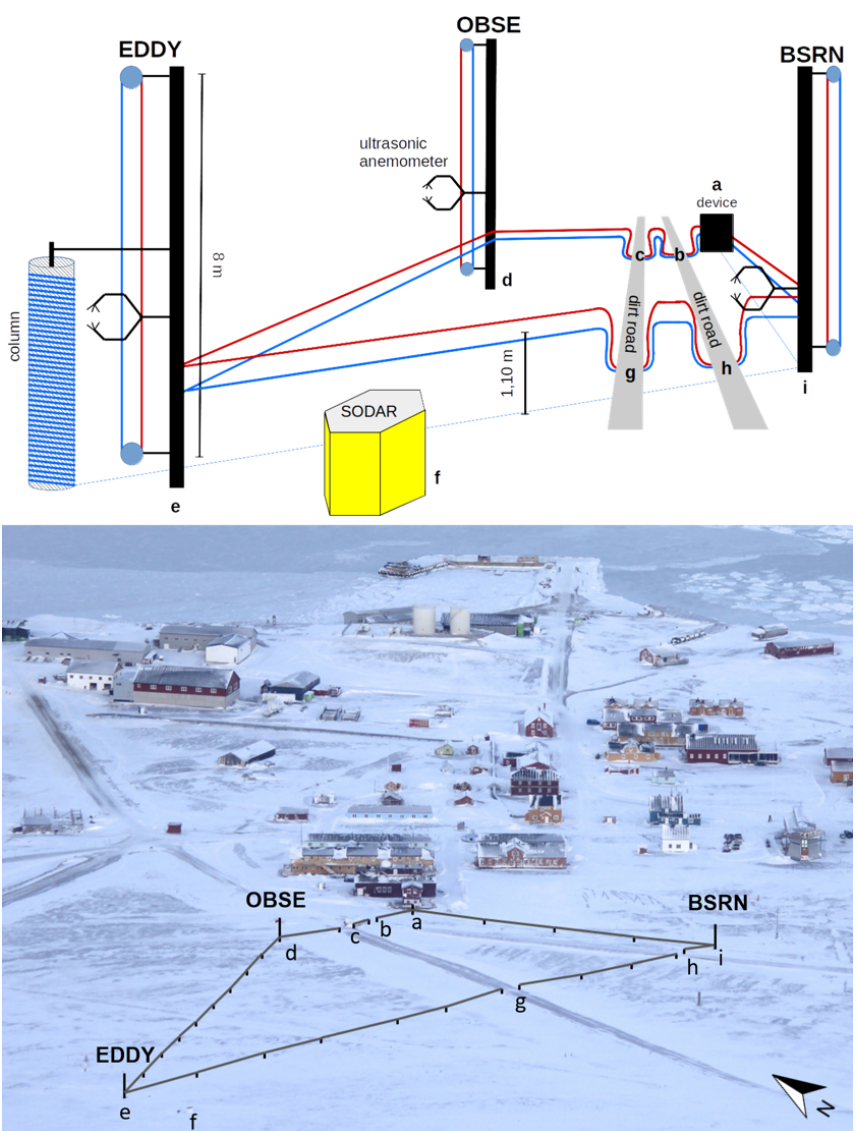
Figure 2. Schematic setup (top panel) and picture of the setup (bottom panel) from the Zeppelin Mountain from the south. The fiber-optic array has a length of 700m. The letters refer to the locations of the FODS device (a); the road crossings (b, c, g, h); the 10m towers (d, e, i), and the minisodar (f). The letters a–i refer to the same elements in both